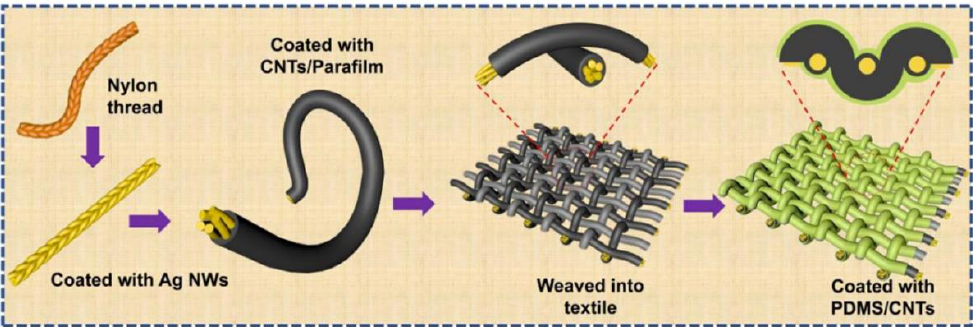
Figure 5. Principle and manufacturing flow chart of piezoresistive fiber triboelectric sensor (PRF- TES) [52]. Yan et al. (2022),